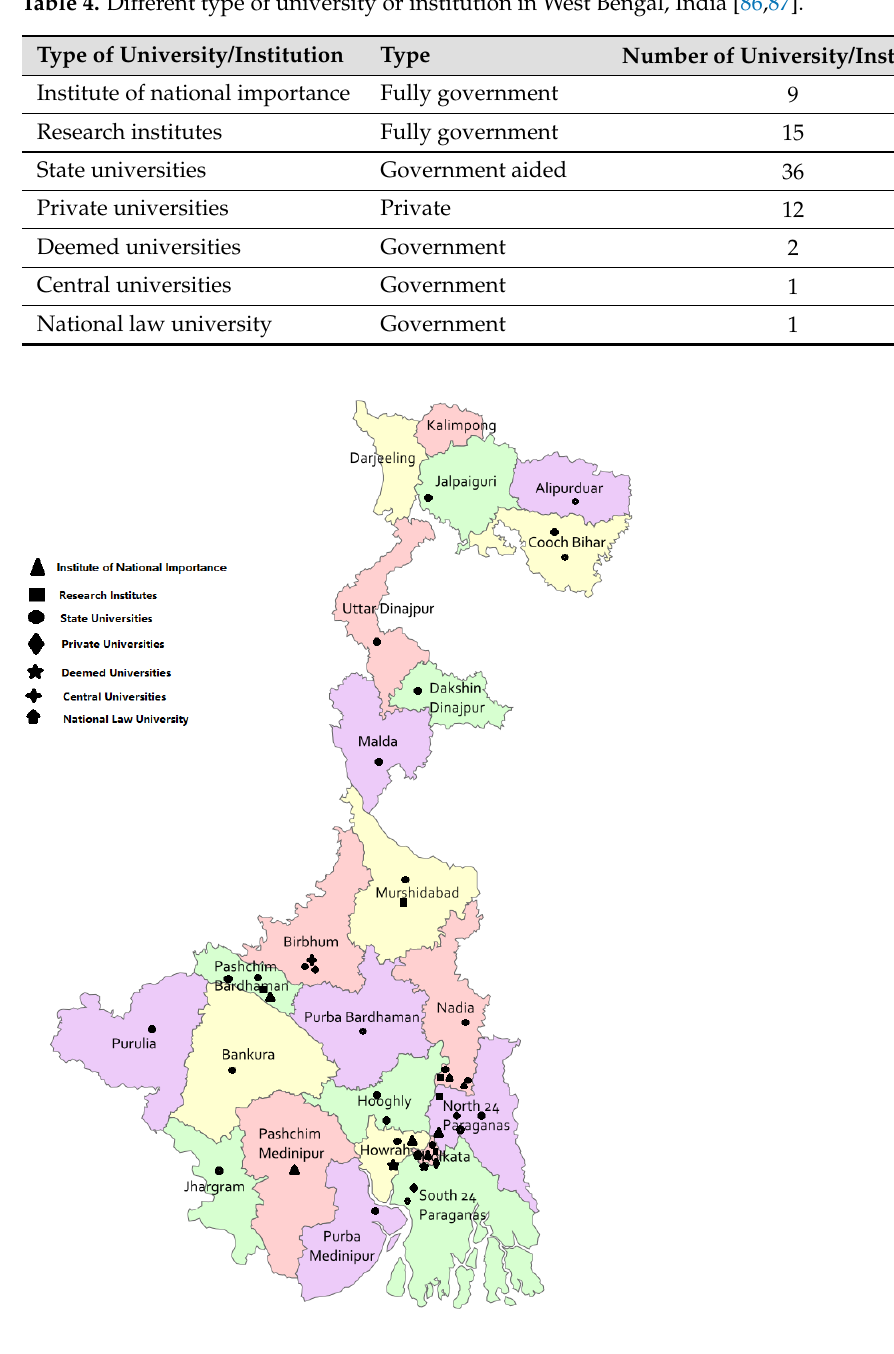
Figure 1. Location wise university & institutions in West Bengal, India